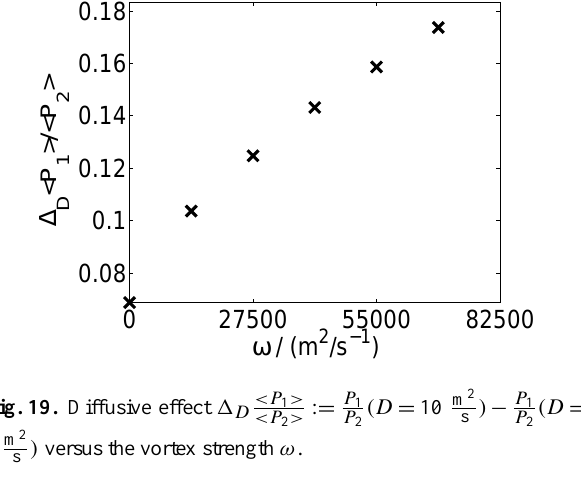
Fig. 18. Ratio of the spatio-temporal average abundance of the two phytoplankton groups versus the vortex , crosses: D = 0 m 2 . strength. circles: D = 10 m 2 s s